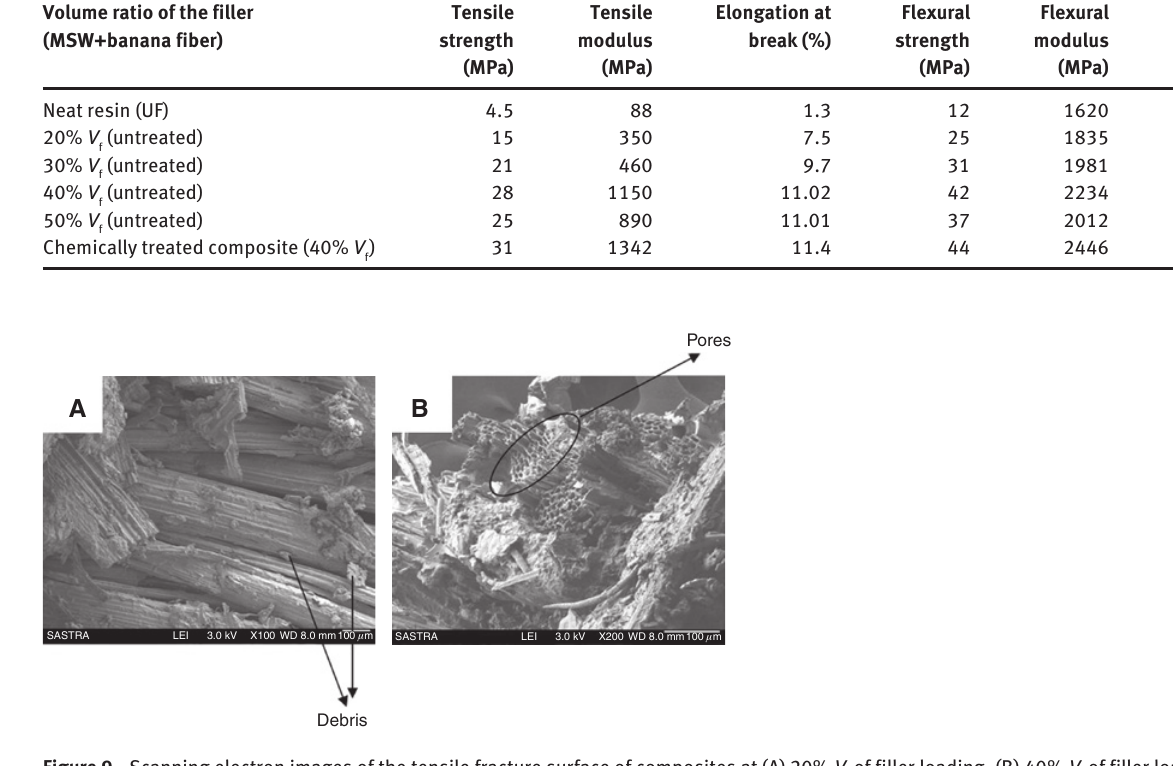
Figure 9 Scanning electron images of the tensile fracture surface of composites at (A) 20% V (ratio of MSW/banana fiber =